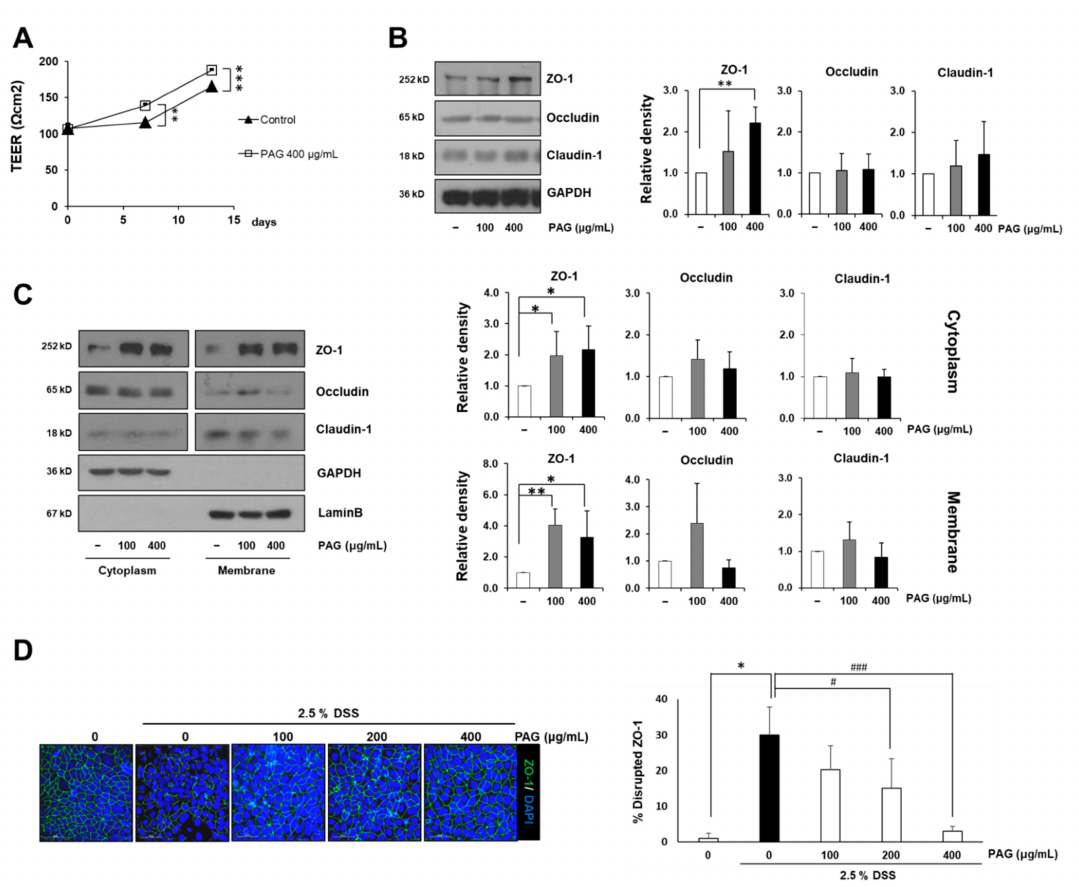
Figure 2. PAG reinforces the intestinal barrier in vitro by increasing expression levels of tight junction proteins. ( A ) Caco-2 monolayers were cultured with or without PAG 400 µ g/mL for 13 days, and trans-epithelial electric resistance values of the monolayers were recorded at days 0, 7, and 13 in triplicate; ( B , C ) Expression levels of tight junction-related proteins in total cell lysate ( B ), cytoplasmic (soluble) fraction and cytomembrane (insoluble) fraction ( C ) of Caco-2 monolayers after 48-h incubation with varying concentrations of PAG; ( D ) 14-day polarized Caco-2 monolayers were incubated with or without 2.5% DSS for 48 h after pre-treatment with PAG 400 µ g/mL for 24 h; immunostaining was subsequently performed to visualize expression levels of the ZO-1 protein. Values are presented as mean ± standard deviation (Student t -test was applied for statistical analysis; *, # p < 0.05; ** p < 0.01; ***, ### p <